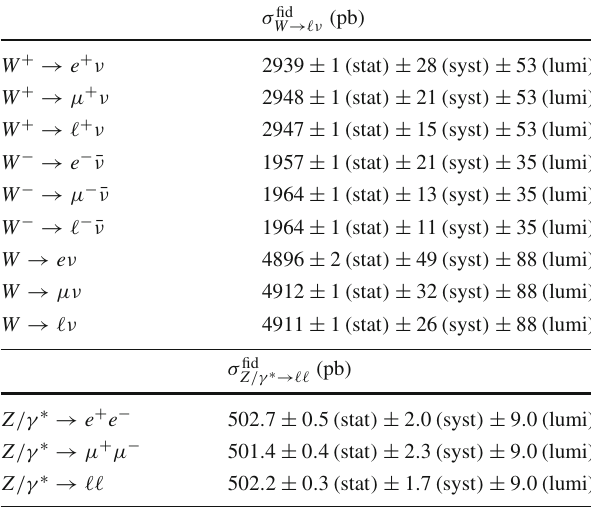
Table 9 Total cross sections times leptonic branching ratios obtained Table 7 Integrated fiducial cross sections times leptonic branching fromthecombinationofelectronandmuonchannelswithstatisticaland ratios in the electron and muon channels and their combination with systematic uncertainties, for W + , W − , their sum and the Z /γ ∗ process statistical and systematic uncertainties, for W + , W − , their sum and √ √ s = 7TeV. The Z /γ ∗ cross section s = 7TeV. The Z /γ ∗ cross section is defined for the the Z /γ ∗ process measured at measured at is defined for the dilepton mass window 66 < m (cid:3)(cid:3) < 116 GeV. The dilepton mass window 66 < m (cid:3)(cid:3) < 116 GeV. The uncertainties denote common fiducial regions are defined in Sect. 2.3. The uncertainties the statistical (stat), the experimental systematic (syst), the luminosity denote the statistical (stat), the experimental systematic (syst), and the (lumi), and acceptance extrapolation (acc) contributions luminosity (lumi) contributions σ tot (pb) W → (cid:3)ν